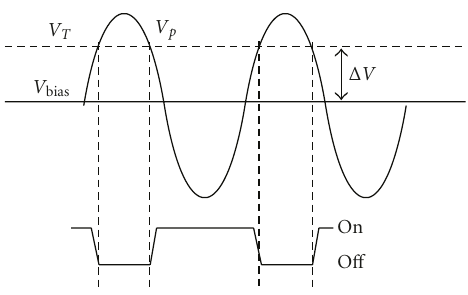
Figure 4: Operating principle of the power amplifier. The di ff erence Δ V between V bias and V T varies, depending on V bias and the resultant PWM drain signal is